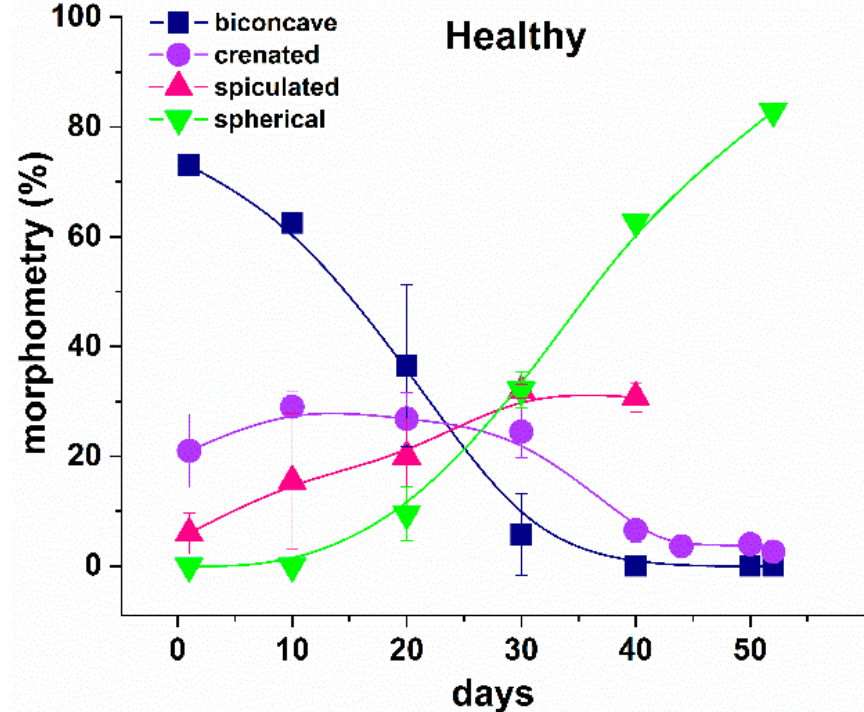
Figure 2. Distribution of the morphological types (in percentage) of healthy RBCs along the aging process, biconcave (navy squares), crenate (violet circles), spiculated (red triangles) and spherocytic (green inverted triangles) shapes. Mean values and SD.